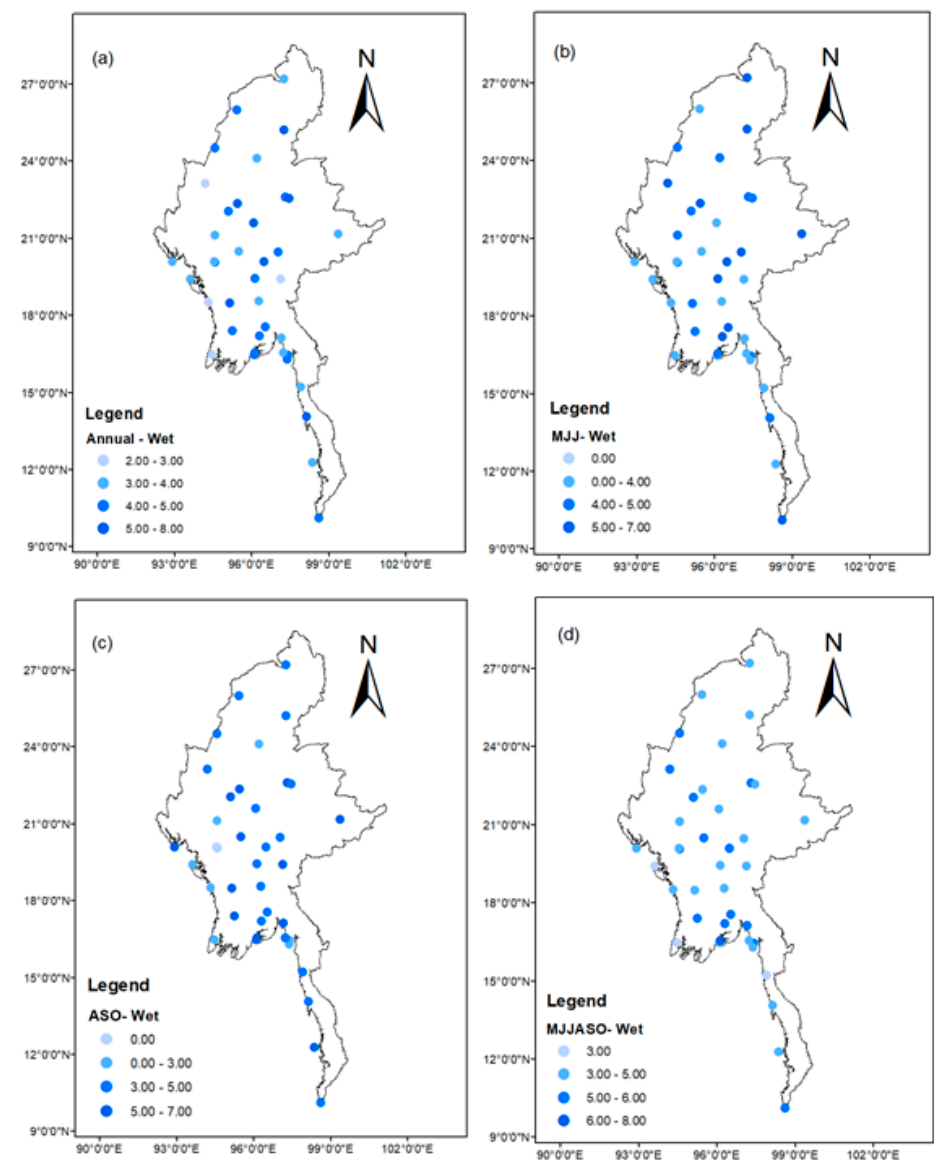
Figure 8. Frequency of drought occurrence of wet spells over Myanmar from 1986 to 2015. ( a ) An- nual, ( b ) MJJ, ( c ) ASO, ( d )